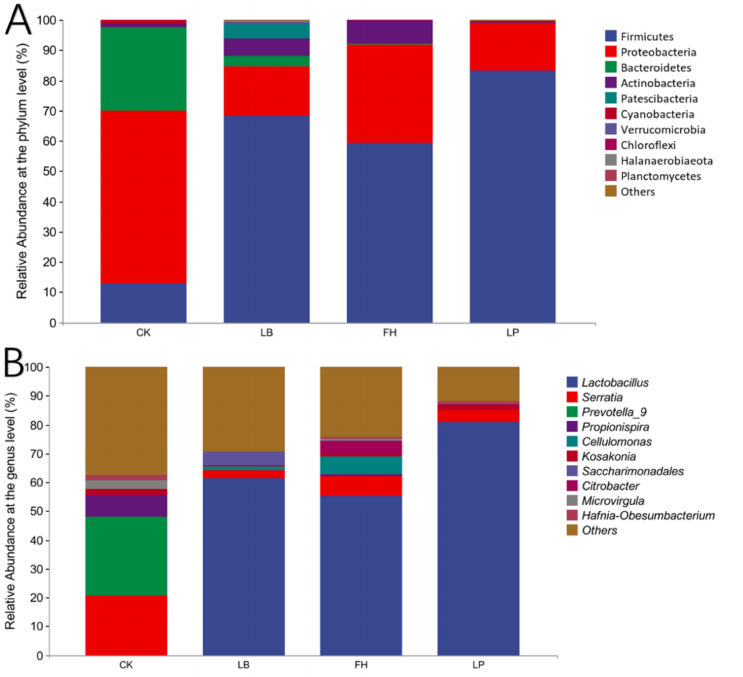
Figure 3. The epiphytic bacterial community in M. aquaticum silage after 60 d of ensiling. The bacterial communities are shown at the phylum level ( A ) and the genus level ( B ). CK, control; LB, Lactobacillus buchneri ; LP, Lactobacillus plantarum ; and FH, combination of LB and LP.